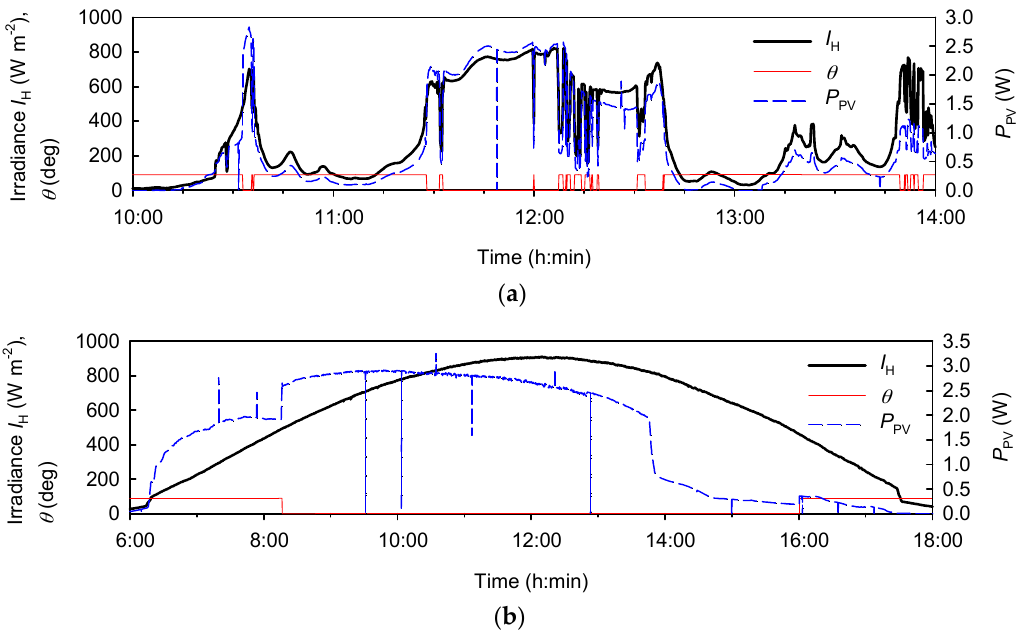
Figure 11. PV blind operations on 12 January ( a ) and 19 April ( b ).